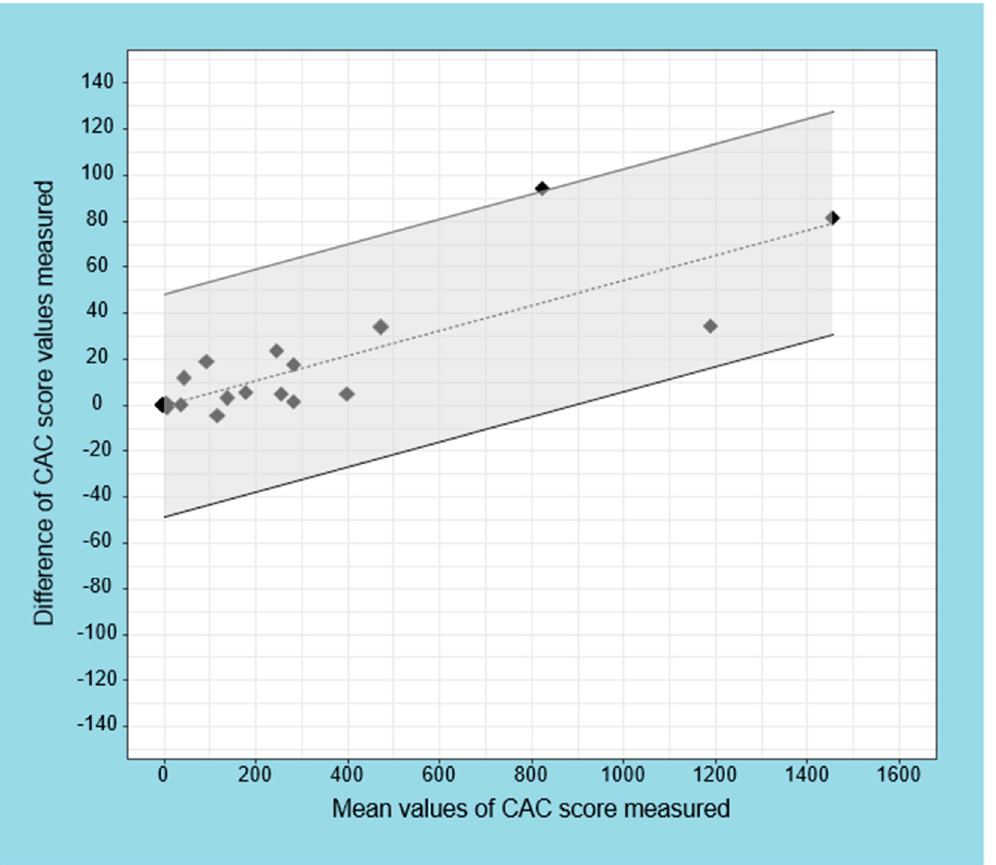
Figure 3. Regression-based limits of agreement for difference in CAC score measured by Horos and LIFEx software. The dashed line represents the fitted regression line, and the continuous lines refer to the 95% CI (gray area). The limits of agreement refer to the Bland–Altman regression method.